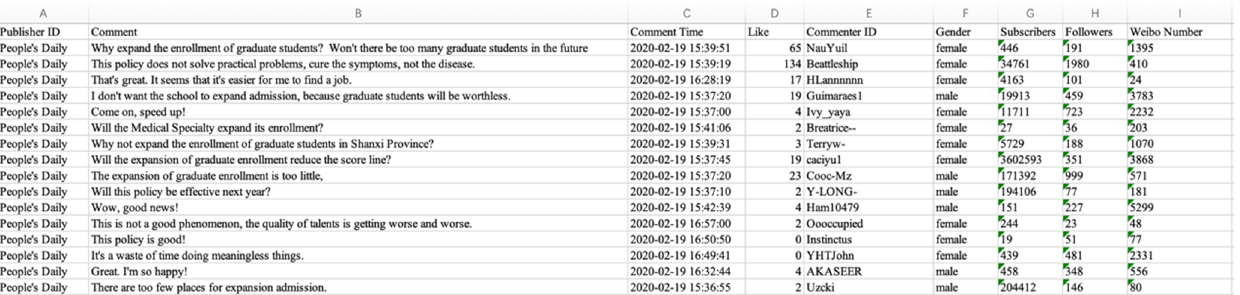
Figure 3. Data format.